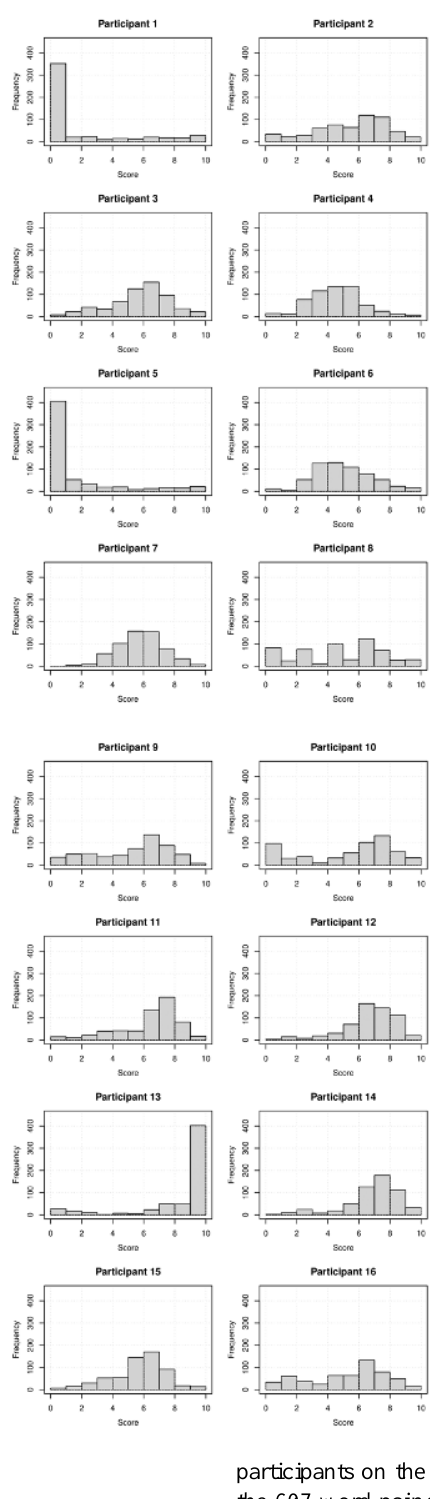
Figure 1. Score distribution plots of the participants (n=16 attending physicians from a tertiary hospital); the distributions of the scores of participants 1, 5, and 13 were absolutely skewed and were therefore excluded from further